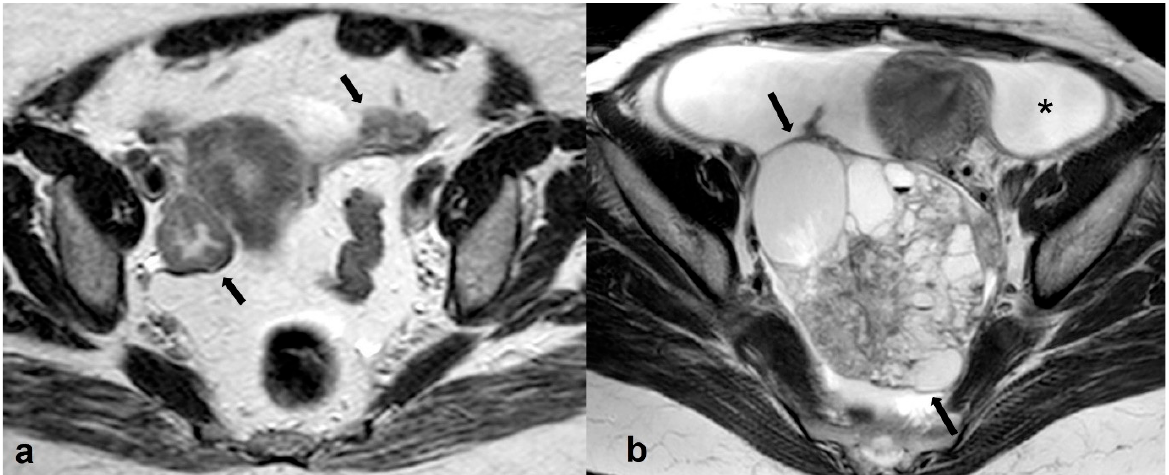
Figure 16. Metastatic ovarian cancer. Axial T2 weighted image ( a ) of a postmenopausal woman with primary gastric cancer. Note the presence of small predominantly solid masses in both ovaries (black arrows). Axial T2 weighted image ( b ) of a premenopausal woman shows a large, mixed cystic, and solid mass in the right adnexa (black arrows) originating from a colon primary. Shown also is a large amount of ascites (asterisk).